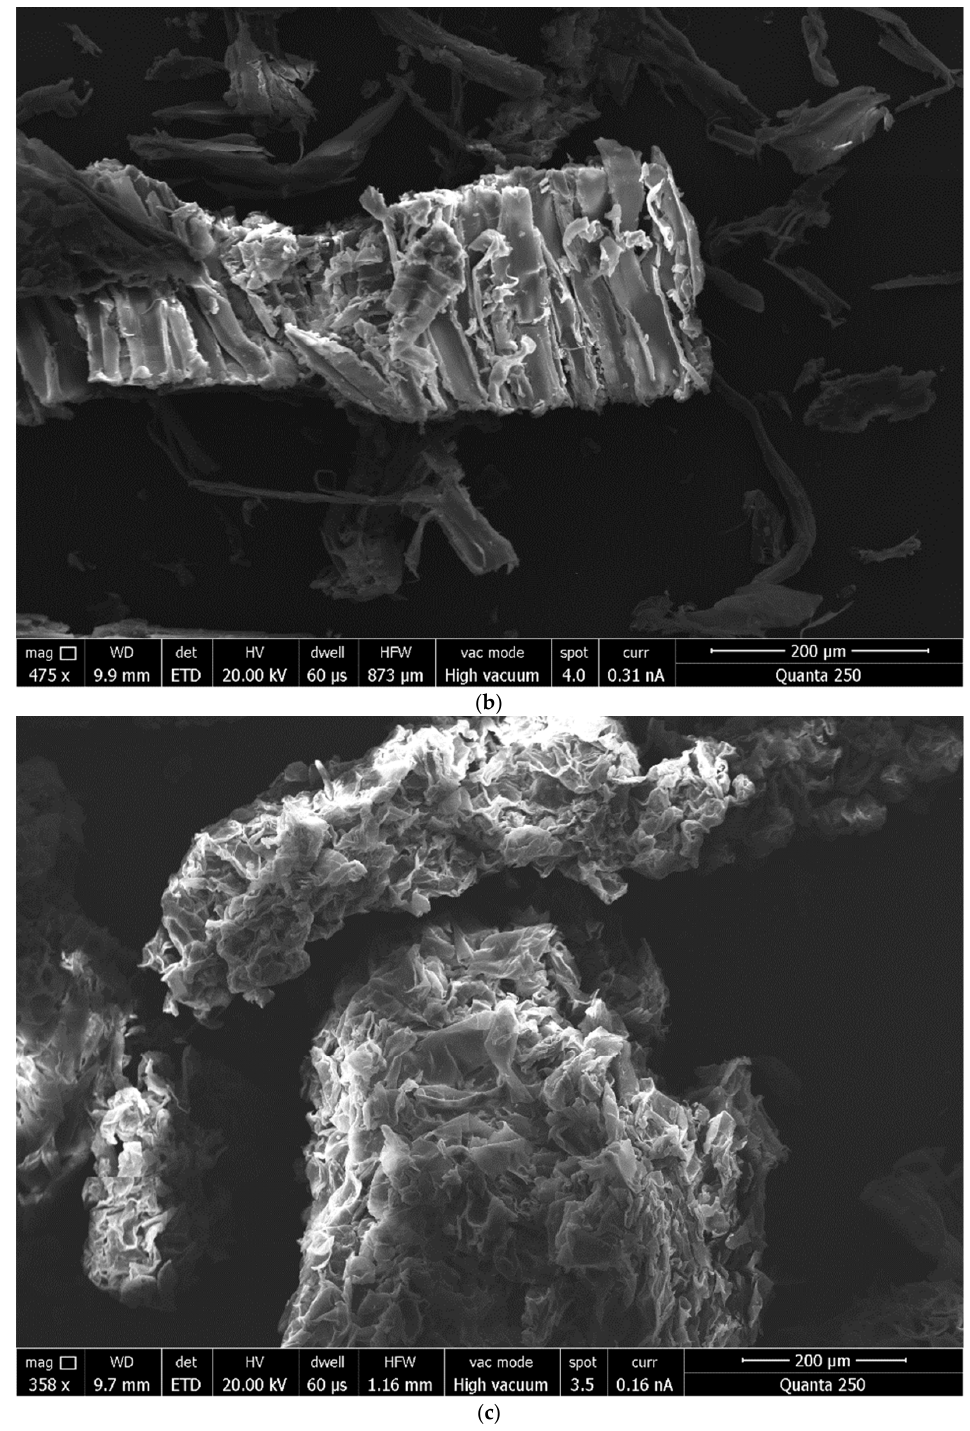
Figure 3. SEM micrographs of raw materials: ( a ) red clay; ( b ) sawdust; ( c ) coconut coir dust.